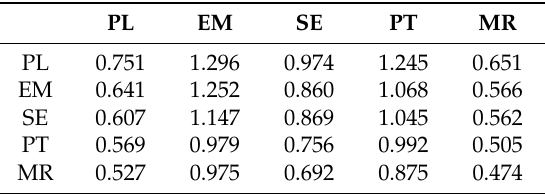
Table 5. Indirect-relation matrix H.